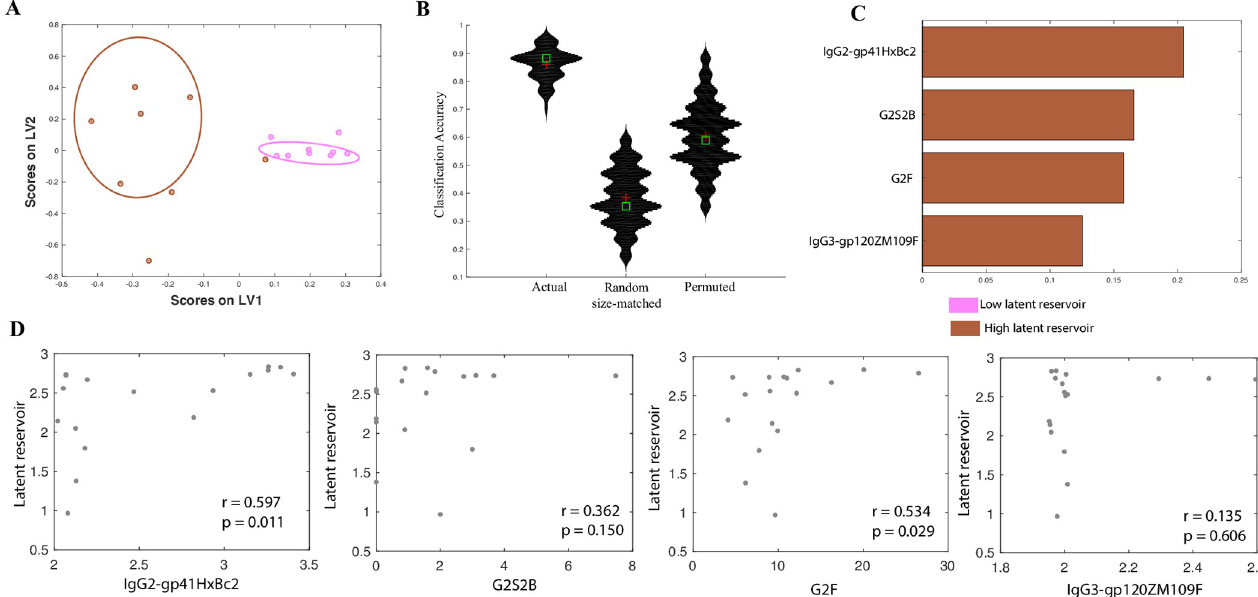
Fig 4. Correlates of latent reservoir size in ART-treated subjects. A. A LASSO-based model is used to classify ART-treated subjects by latent reservoir size. The LASSO-selected features are visualized in 2 dimensions using a PLSDA LV scores biplot. B iolin plots showing classification accuracy of the actual model from (a) and of 2 negative control models (based on randomly selected features & permuted data), as measured in a 5-fold cross validation framework. Exact P values (actual vs permuted and actual vs random-size matched) confirm significance of the model. C. PLS VIP plot corresponding to the features in (a) used to classify subjects by latent reservoir size. D. Correlations between biomarkers of the latent reservoir in ART-treated subjects, and actual latent reservoir size.